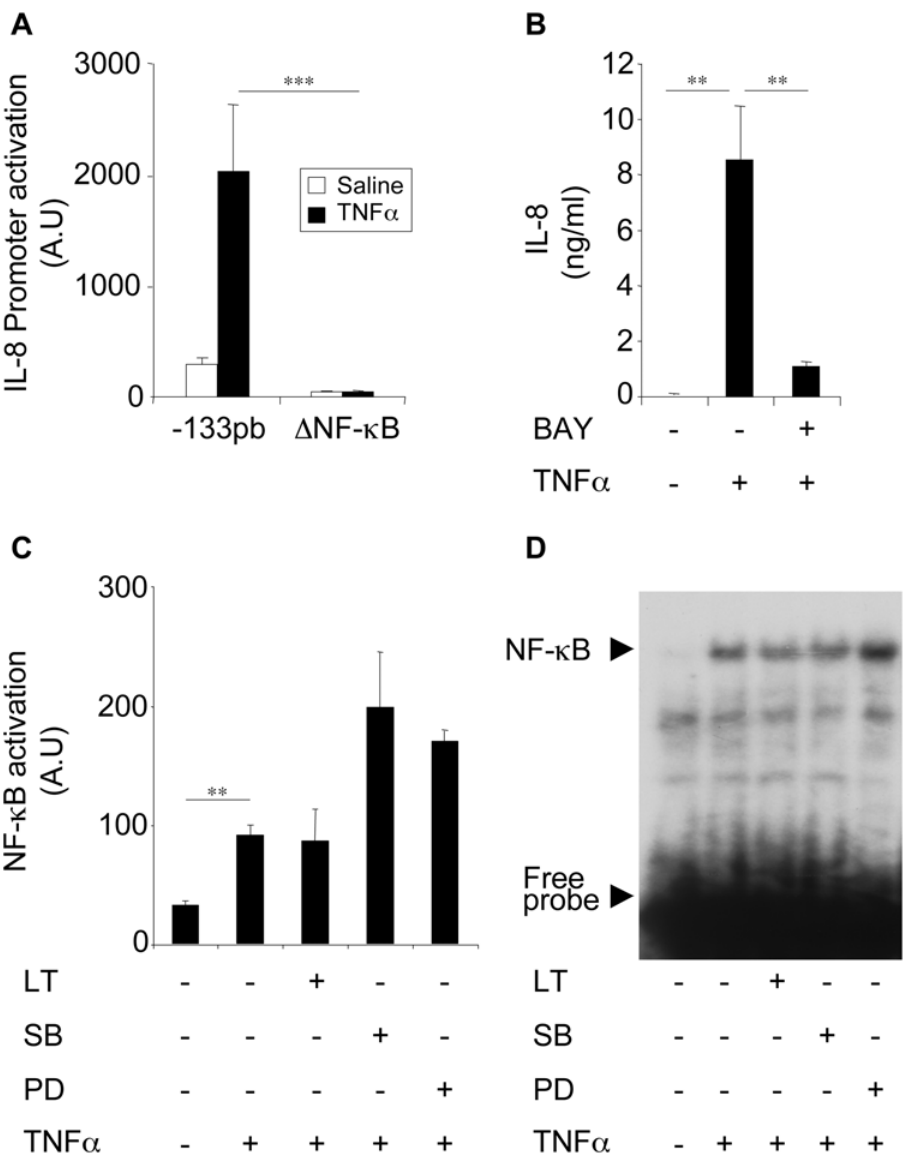
Figure 3. LT inhibits IL-8 expression through a process independent of NF- k B activation. (A) Beas-2B cells were transfected with IL-8 promoter ( 2 133 pb) or [ D NF- k B] IL-8 promoter reporter plasmids before stimulation with TNF a (10 ng/ml). Luciferase activity was measured after 24 h stimulation. (B) Cells were pretreated with BAY (10 m M) for 1 h and stimulated with TNF a (10 ng/ml). IL-8 concentrations were measured in supernatants after 24 h stimulation. (C) Cells were pretreated for 1 h with LT (1 m g/ml), SB203580, or PD98059 and incubated with TNF a (10 ng/ml). NF- k B luciferase activity was analysed after 24 h stimulation. (D) Cells were pretreated with LT (1 m g/ml), SB203580 (10 m M), or PD98059 (10 m M) and then stimulated with TNF a (10 ng/ml) for an additional 2 h. NF- k B translocation was analysed by